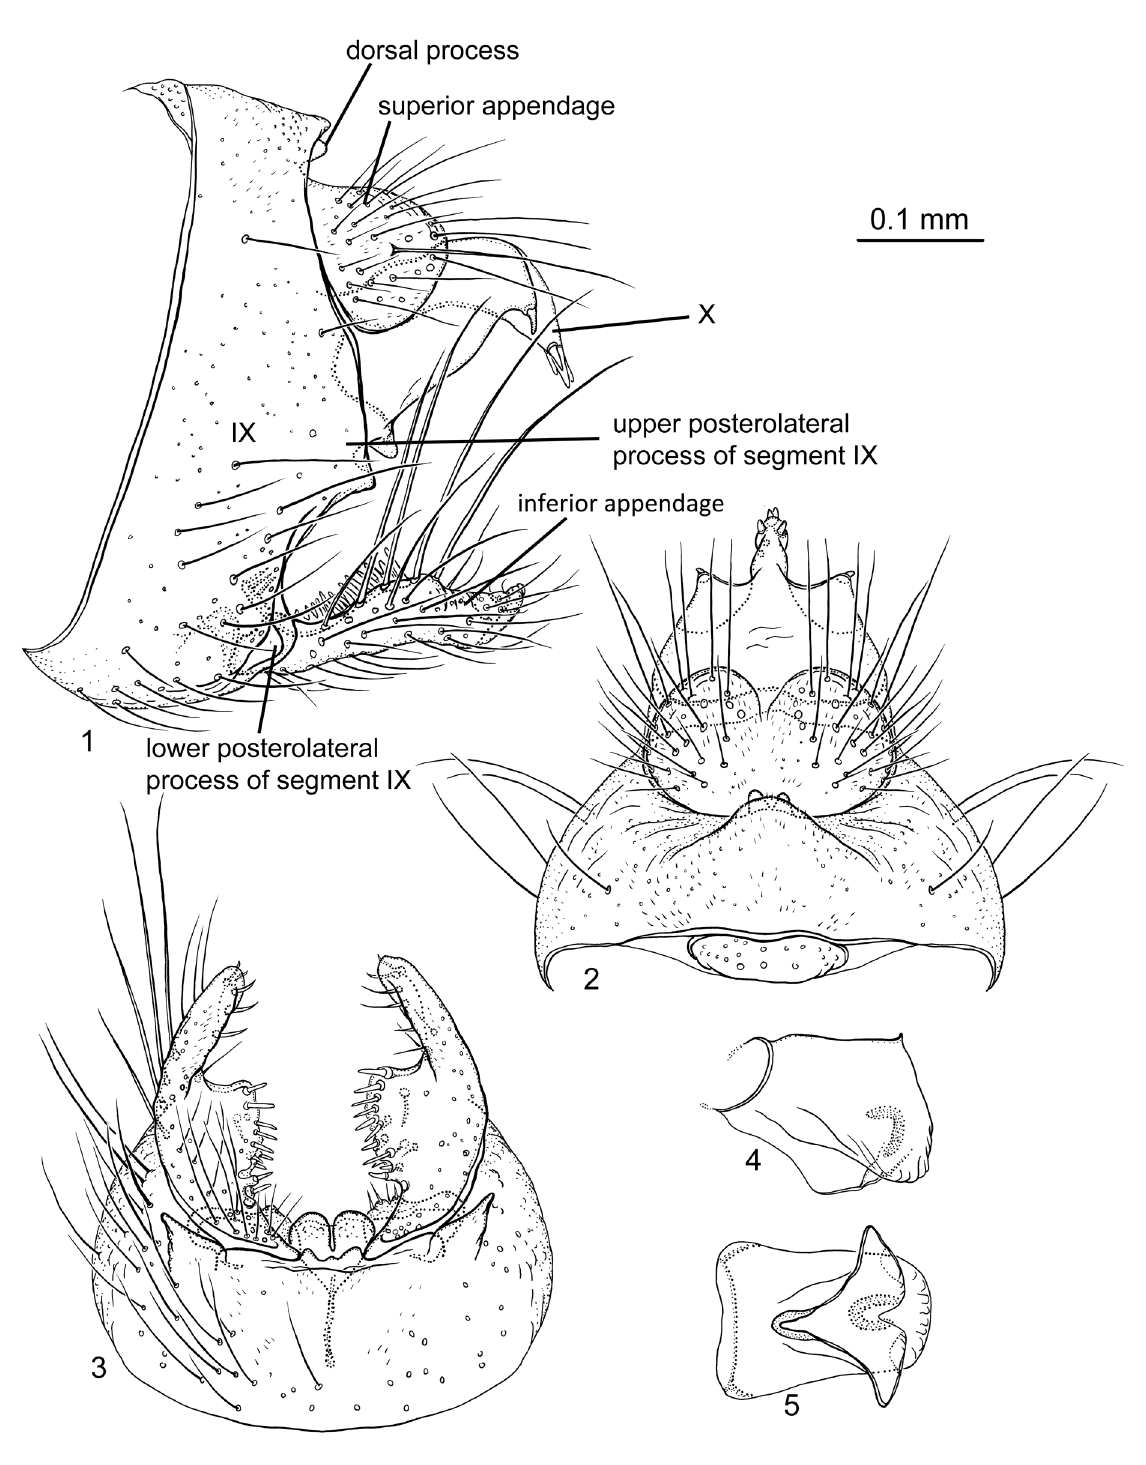
Figs 1–5. Oecetis mesospina sp. nov., holotype, ♂ (NHRS). 1 . Genitalia, lateral view. 2 . Genitalia, dorsal view. 3 . Genitalia, ventral view. 4 . Phallus, lateral view. 5 . Phallus, ventral. Scale bar = 0.1